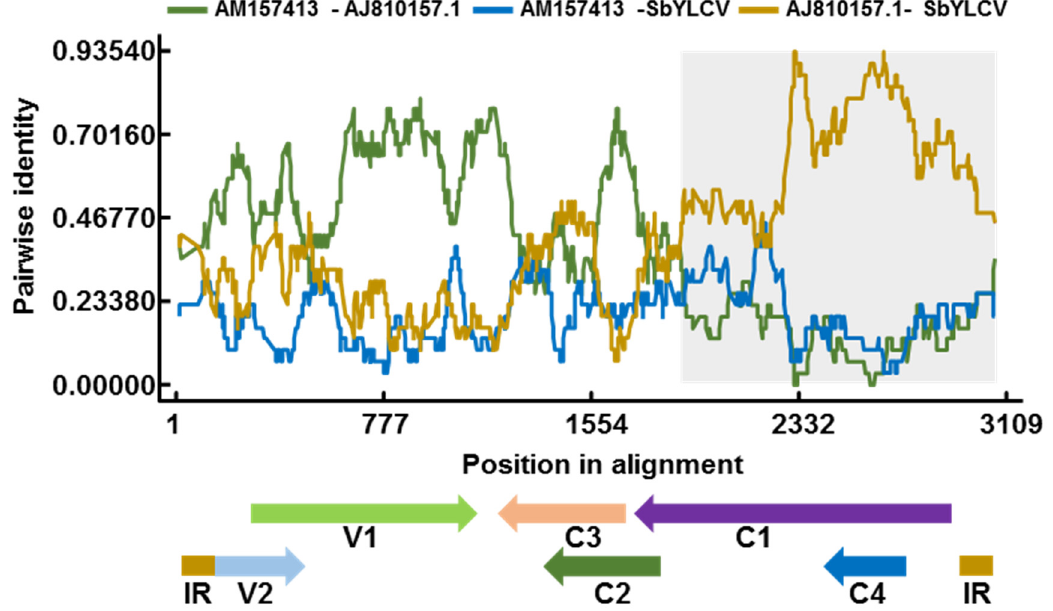
Figure 4. Recombination analysis of SbYLCV. The recombinant event was detected using the Re- combination Detection Program RDP4. The brown line indicates the pairwise identity between the minor parent (Stachytarpheta leaf curl virus, AJ810157.1) and SbYLCV. The grey region represents the location of predicted breakpoints. The displayed linearized genome organization of SbYLCV shows the position in the alignment.